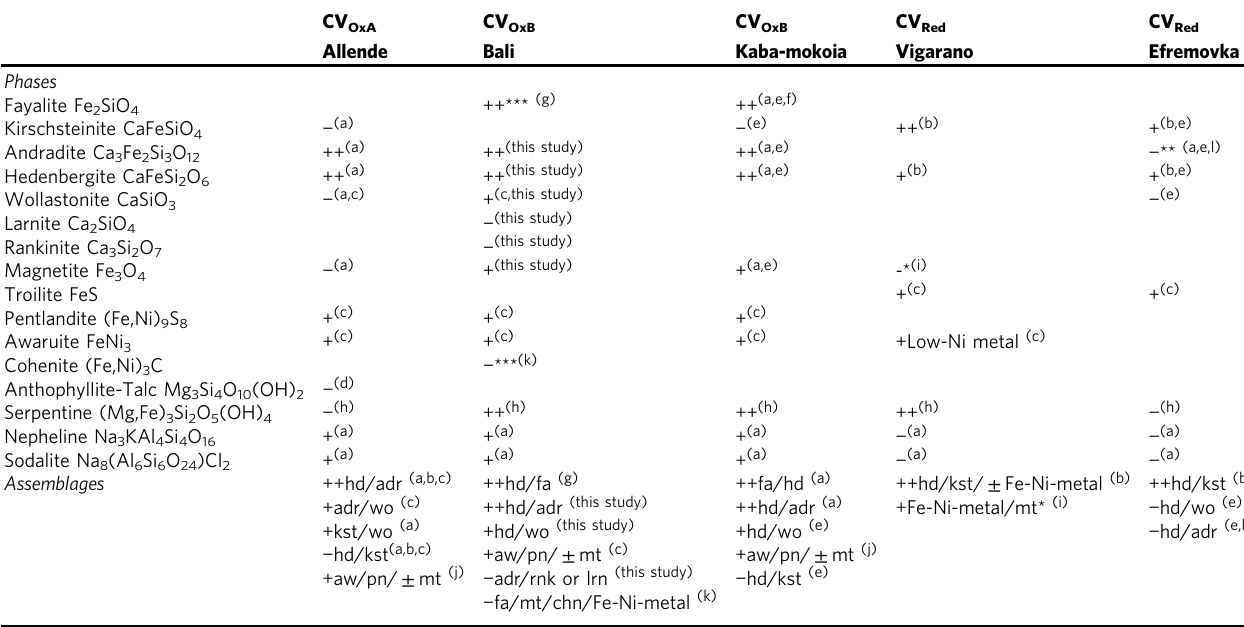
Table 1 Survey of secondary minerals in CV3 chondrites matrices CV